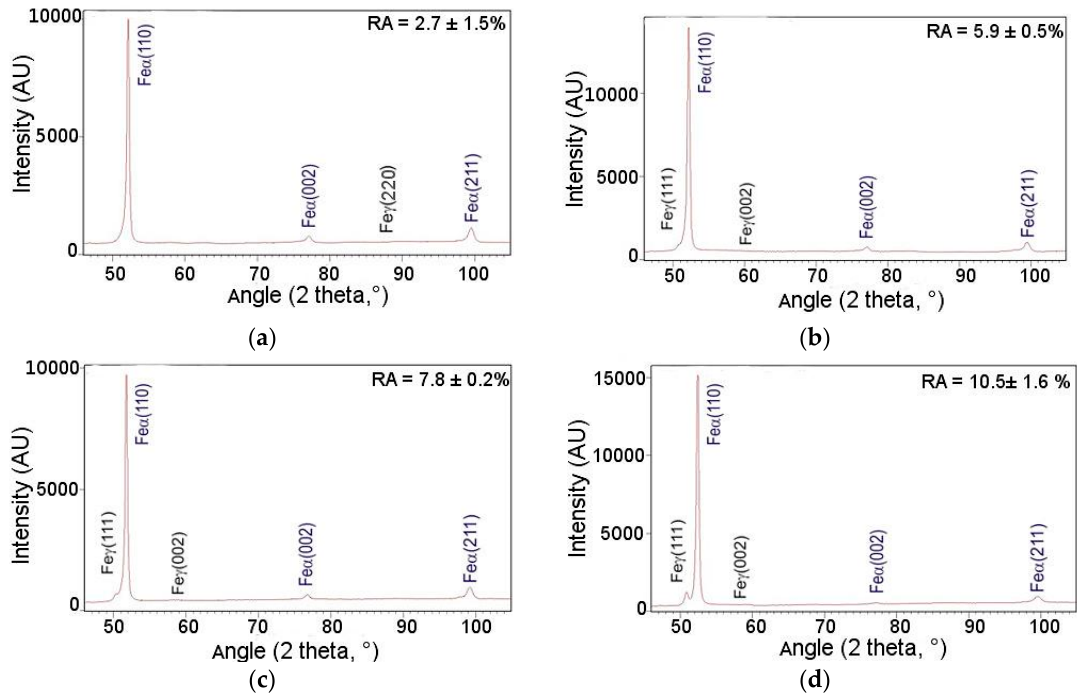
Figure 13. X-ray diffraction patterns of investigated steel deformed at: 20 °C ( a ), 60 °C ( b ), 100 °C ( c ), 200 °C ( d ). Table 2. Average amount of retained austenite at different deformation temperatures determined using EBSD and XRD methods, carbon content in RA, and corresponding total elongation values. Fraction of Retained Deformation Austenite, vol.% Temperatures, °C